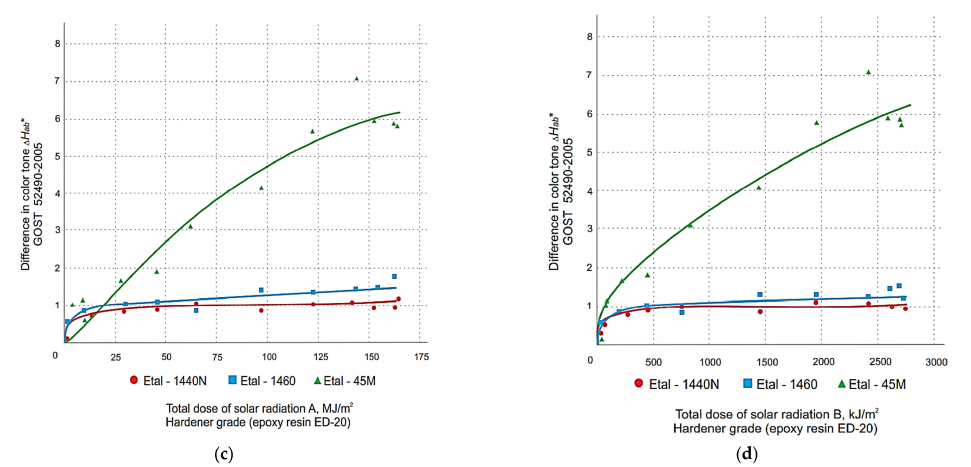
Figure 3. Change in the difference in the color tone of polymers based on epoxy resin ED-20 depending on the duration of exposure ( a ), total solar radiation ( b ), total ultraviolet radiation of the range A ( c ) and B ( d ) when exposed under the influence of climatic factors.